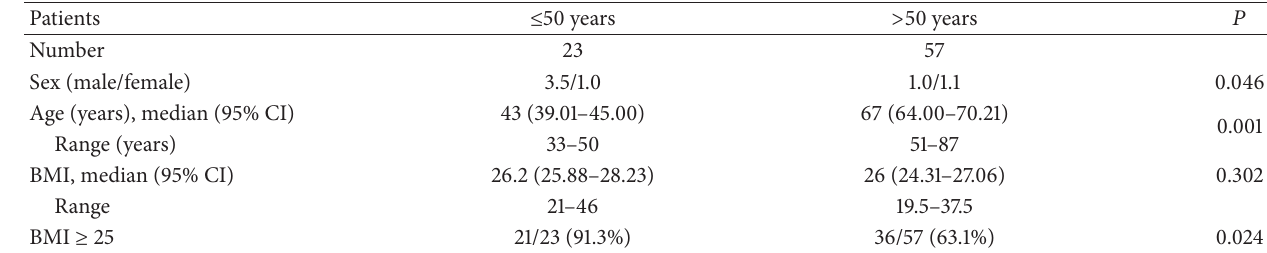
Table 1: Patients’